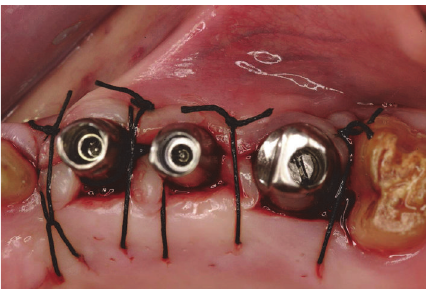
Figure 29: A conservative type of uncovering to preserve and augment the KG tissue present was required.